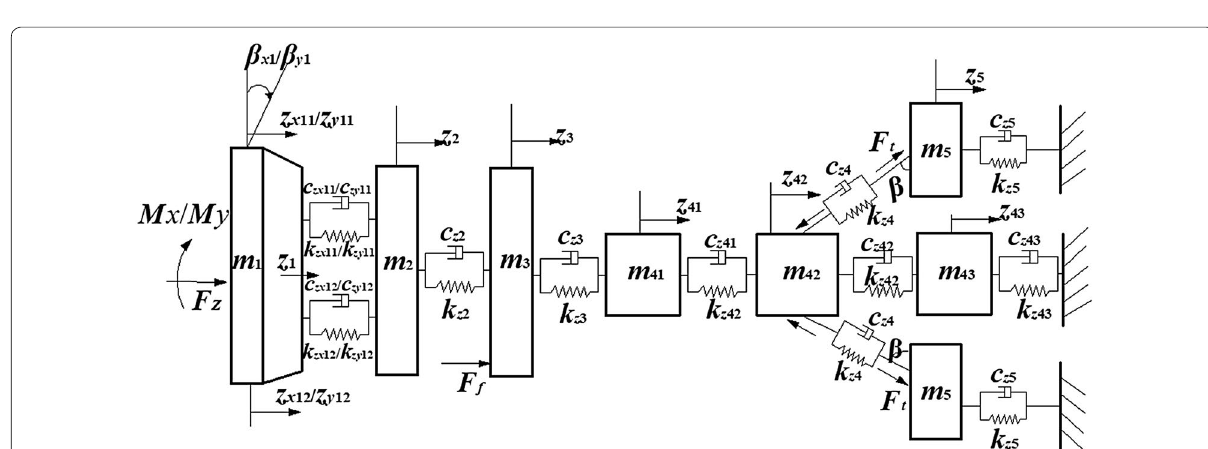
Figure 3 Coupling dynamic model of the tunneling and overturning vibrations of the TBM